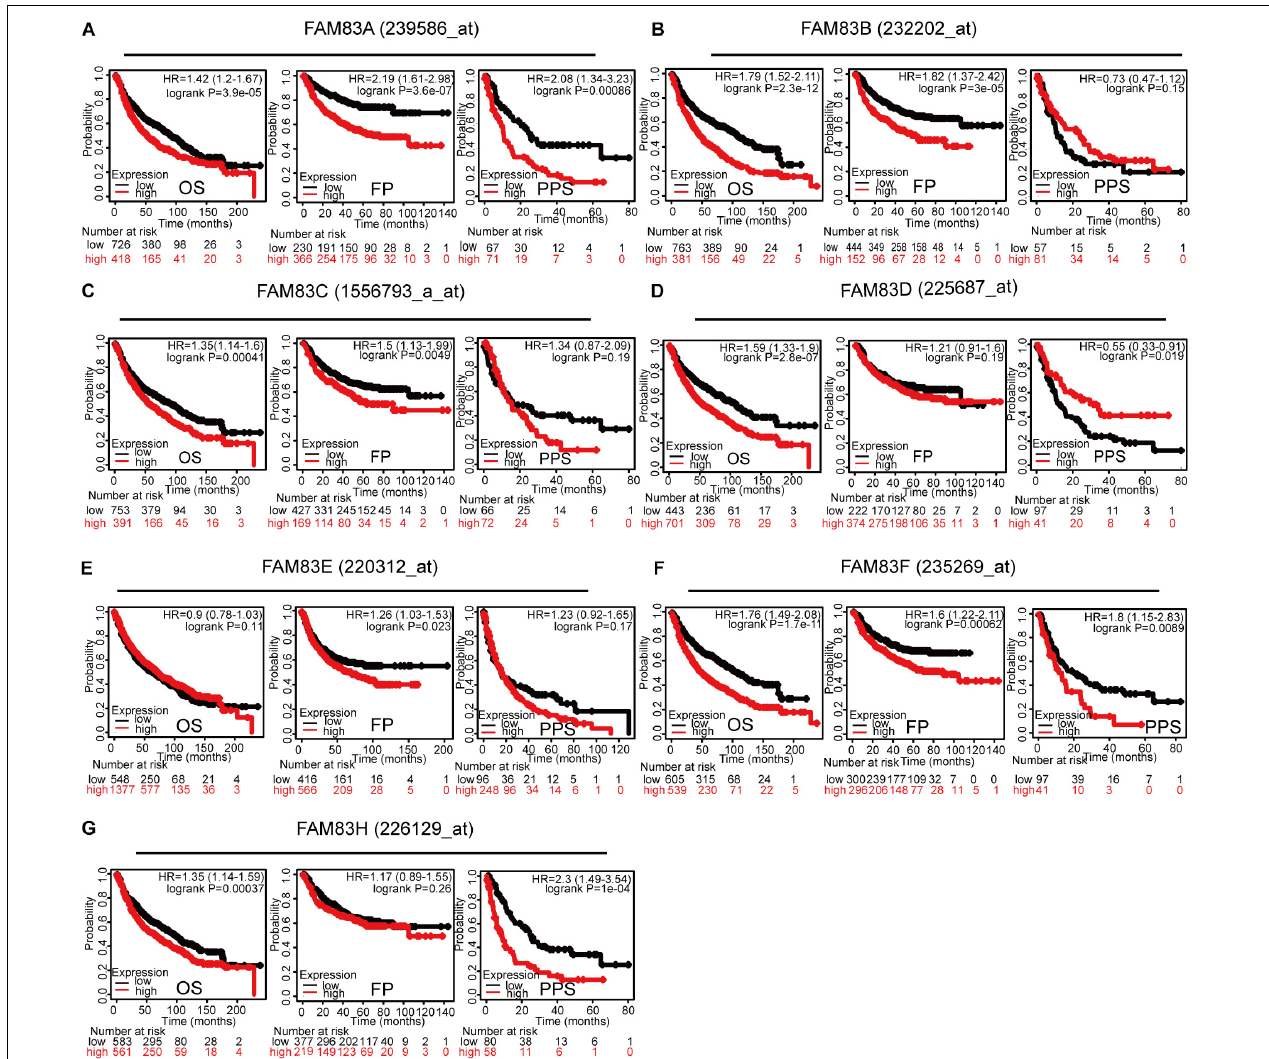
FIGURE 5 | Prognostic feature of mRNA expression of distinct FAM83 family members in lung cancer patients (Kaplan–Meier plotter). The OS, FP, and PPS survival curves comparing patients with high (red) and low (black) FAM83 family member expression in lung cancer were plotted using the Kaplan–Meier plotter database at the threshold of p -value of < 0.05. The association between Prognostic value and (A) FAM83A, (B) FAM83B, (C) FAM83C, (D) FAM83D, (E) FAM83E, (F) FAM83F, (G) FAM83H protein expression.